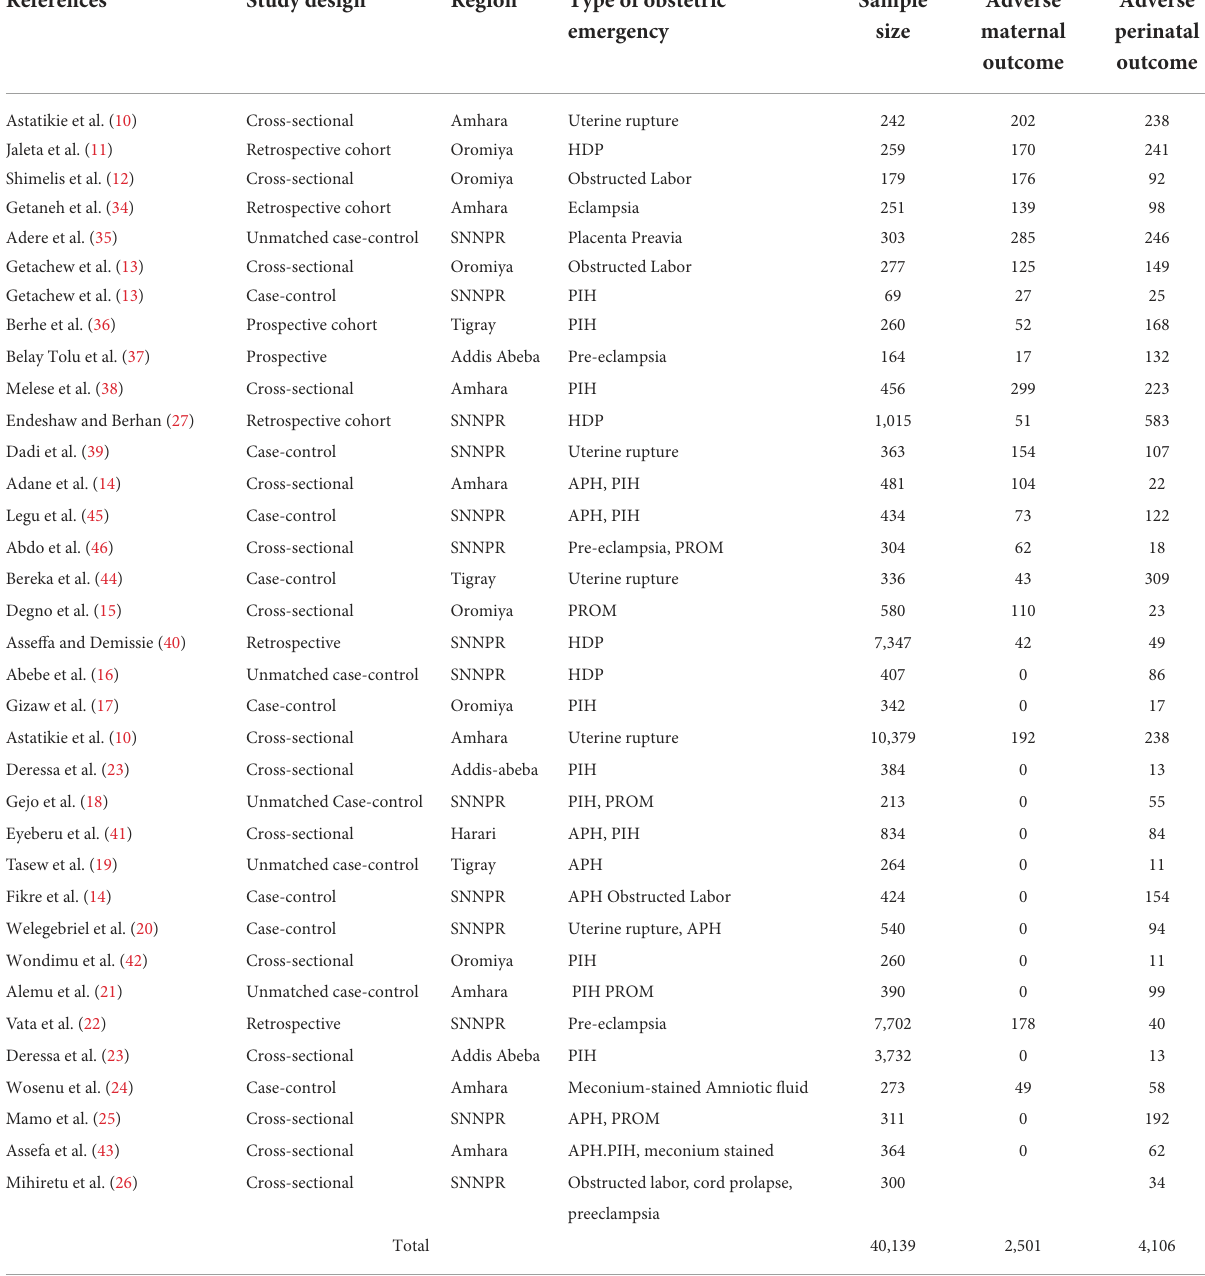
TABLE 1 Characteristics of included studies in